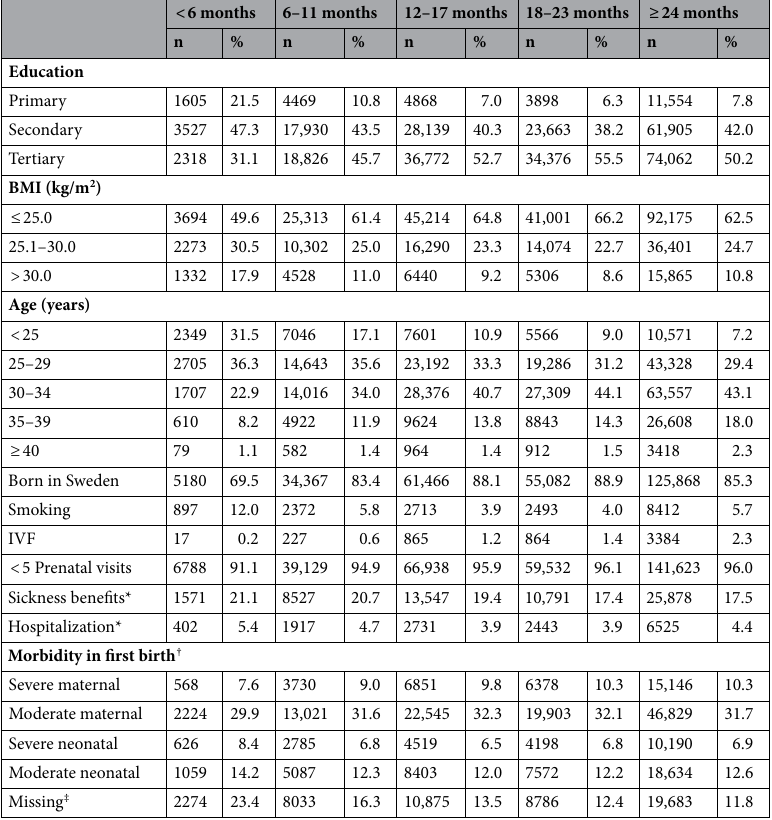
Table 1. Maternal characteristics across interpregnancy intervals. *Prior to first birth. † According to definitions in Supplementary tables S1 and S2. ‡ Women with missing information on at least one